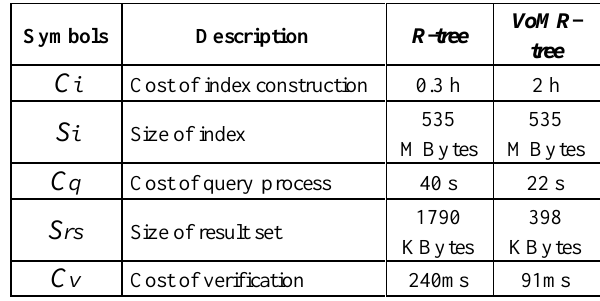
Table 1. Symbols and values in analysis